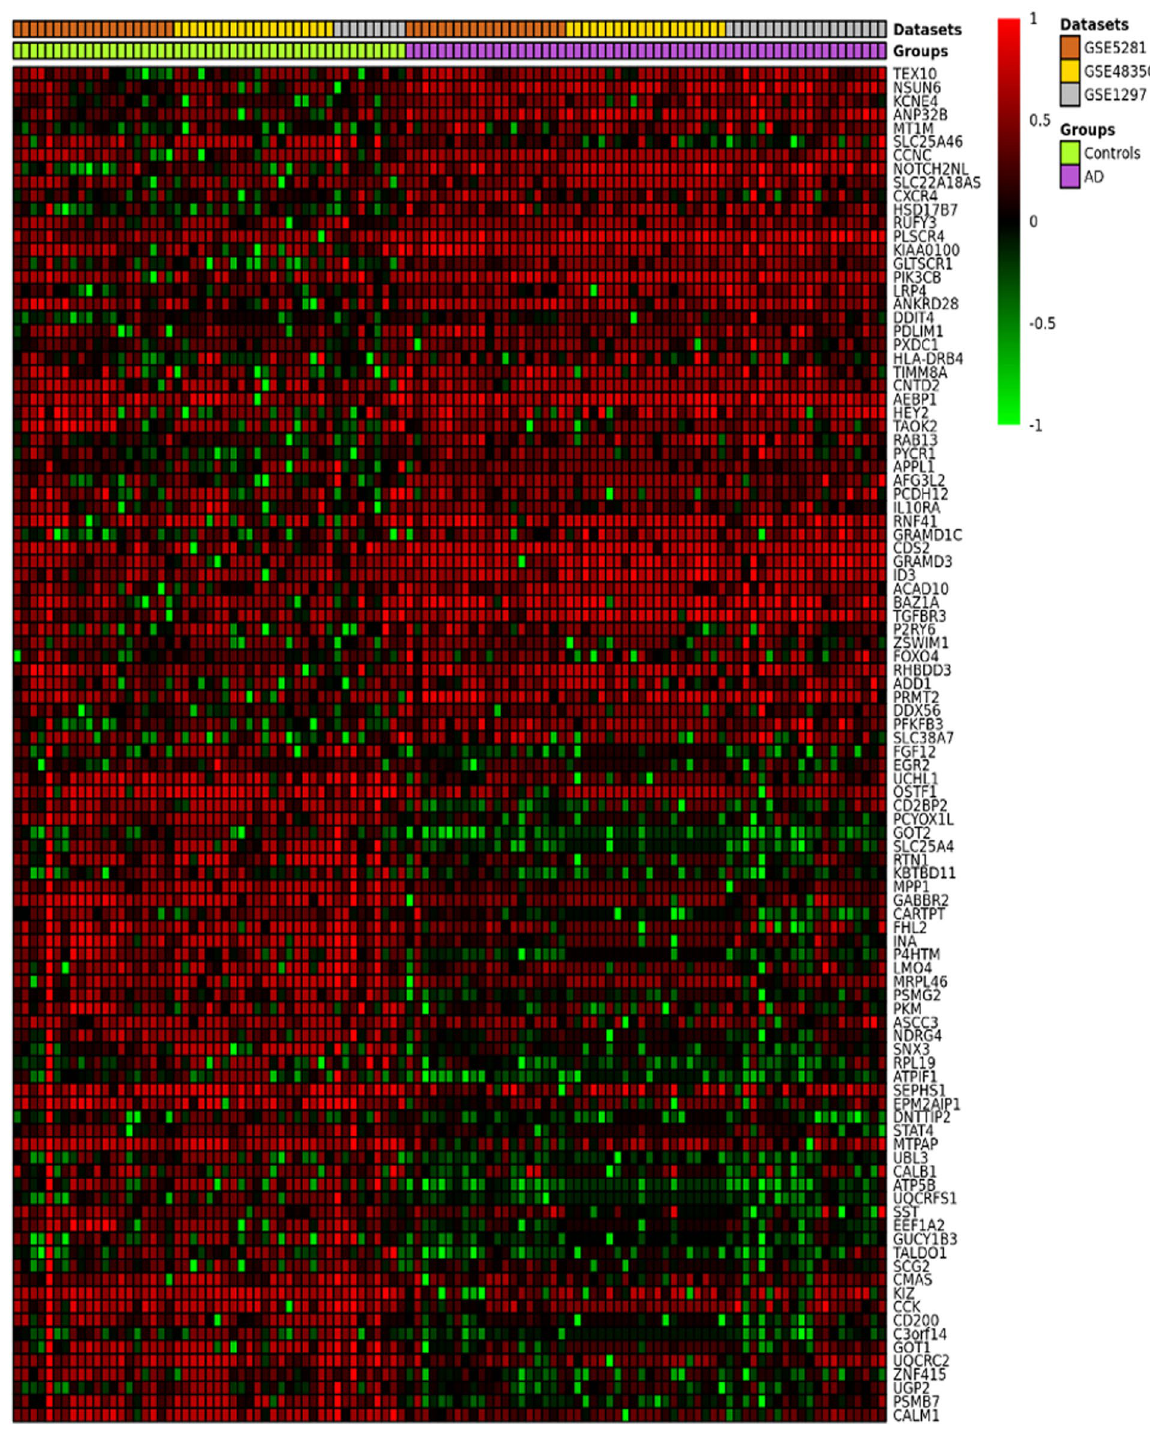
Figure 2. An ImaGEO generated heatmap of the top-100 DEGs (Red represents the relative upregulated gene expression; green represents the relative downregulated gene expression; black represents no significant change in gene